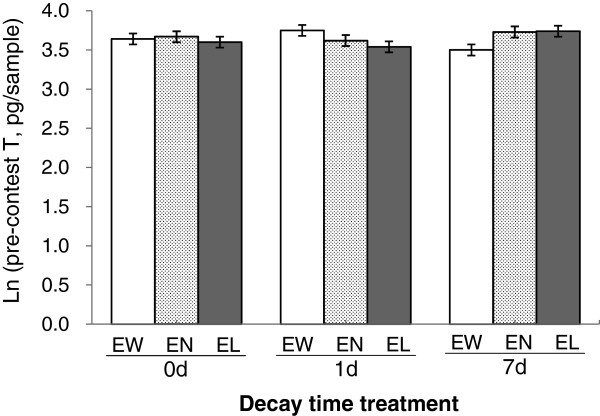
Pre-contest T levels for the focal individuals assigned to different contest experience × time-decay treatments. Means (± SE) are least squares means adjusted for pre-experience T level and strain type. Within each of the time-decay treatments, none of the pair-wise differences between different experience treatments reached significance (Tukey multiple comparisons, all P > 0.05).